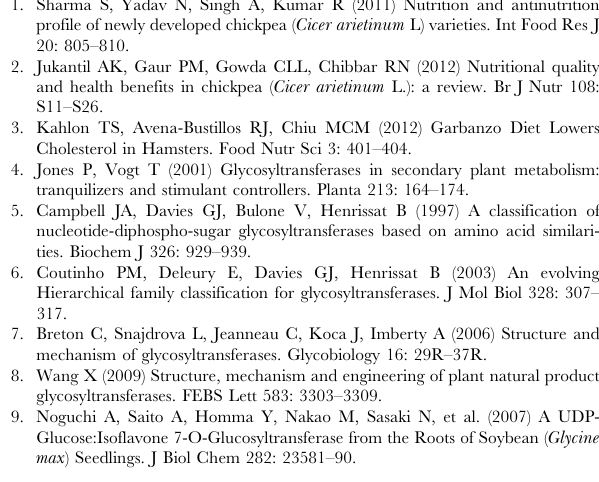
Figure S1 Surface representation of UGT88E9 with bound quercetin (Yellow) and UPG (blue) shown in stick form. The NTD and CTD are shown in red and green color with the interdomain linker marked by arrows (The image is drawn in PyMOL). Figure S2 Multiple sequence alignment of 96 chickpea UGTs. The important conserved residues of PF00201 pfam family are marked with an arrow. This and the following sequence alignments are generated using ClustalX [58]. Figure S3 Multiple sequence alignment of four chickpea UGTs (by MEME-MAST), Ca_27131 and Ca_19130] identified by HMM search. Figure S4 Gene identification statistics. The number of Ca UGTs predicted using various methods such as PSWM search in MEME-MAST, Blastp and HMM-profiles shown with the help of a Venn diagram. Figure S5 Multiple sequence alignment of chickpea UGTs with experimentally validated UGT proteins. Regions marked in boxes are important for acceptor specificity. Figure S6 Multiple sequence alignment of chickpea UGT protein sequences and their respective templates utilized for the homology modeling studies. Figure S7 Standard deviation plot of chickpea UGTs. Figure S8 Distribution of expression (FPKM) values for all the expressed genes in various tissues. Violin plot representing distribution of FPKM values of all the expressed genes (FPKM . 0) in different tissues. Natural